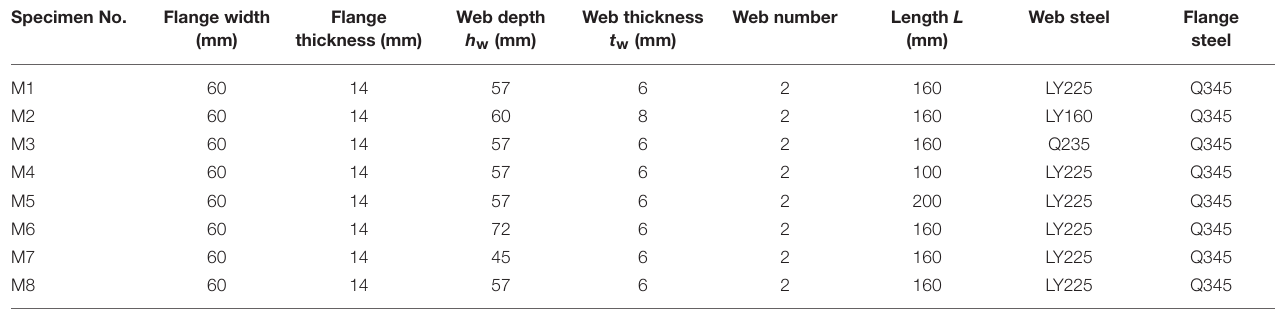
TABLE 1 | Detailed parameters of metallic dampers. Specimen No.